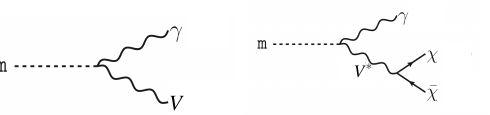
Figure 154. Production of fermionic DM via two-body neutral pseudoscalar meson decay m when M V < m m ( left ) or via three-body decay with off-shell V m